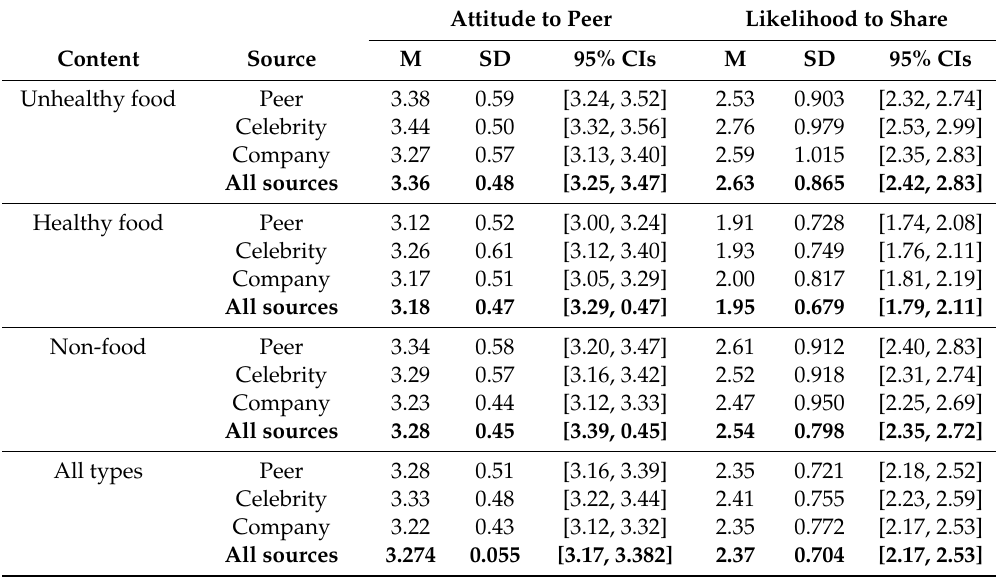
Attitude to peer and likelihood to share: Means, standard deviations, and 95% confidence